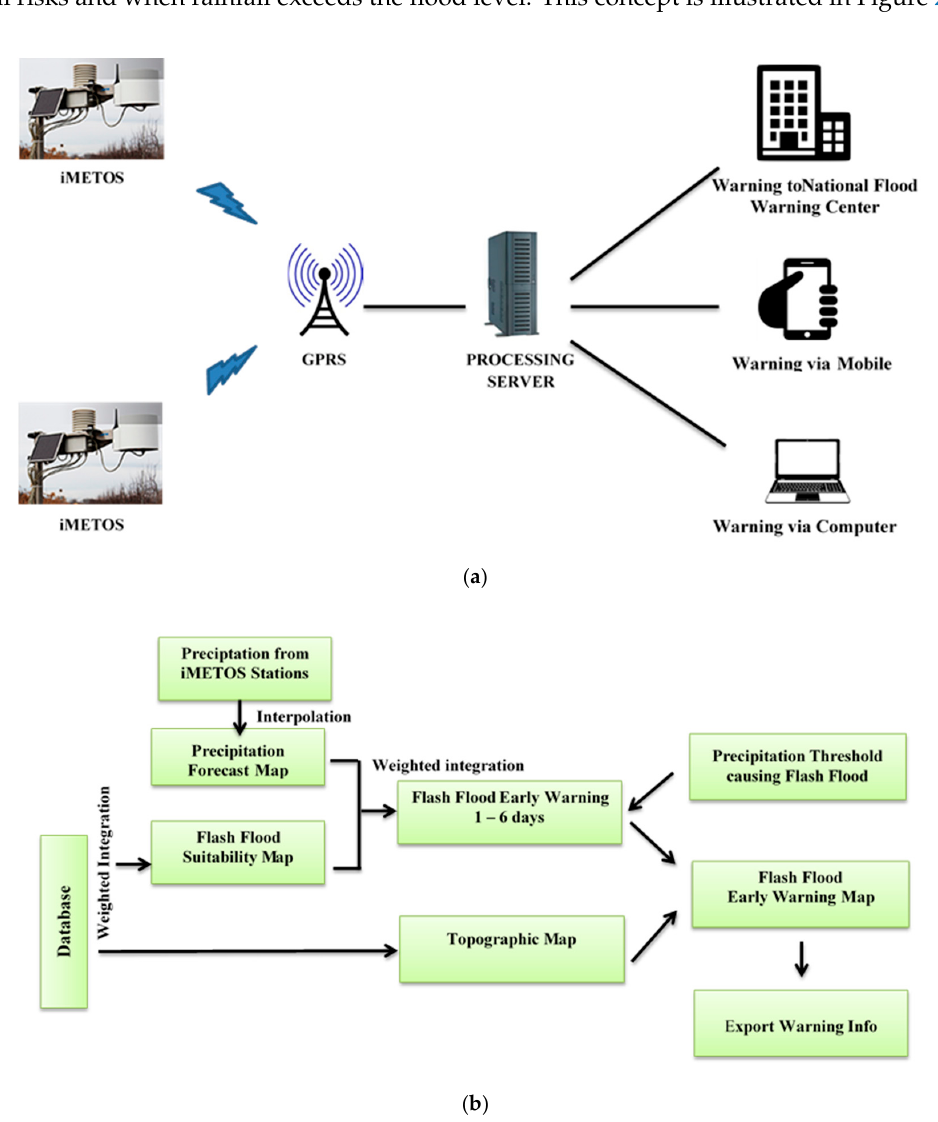
Figure 2. ( a ) Model of information processing and integration, ( b ) Workflow of the processing server for early flash flood warning.